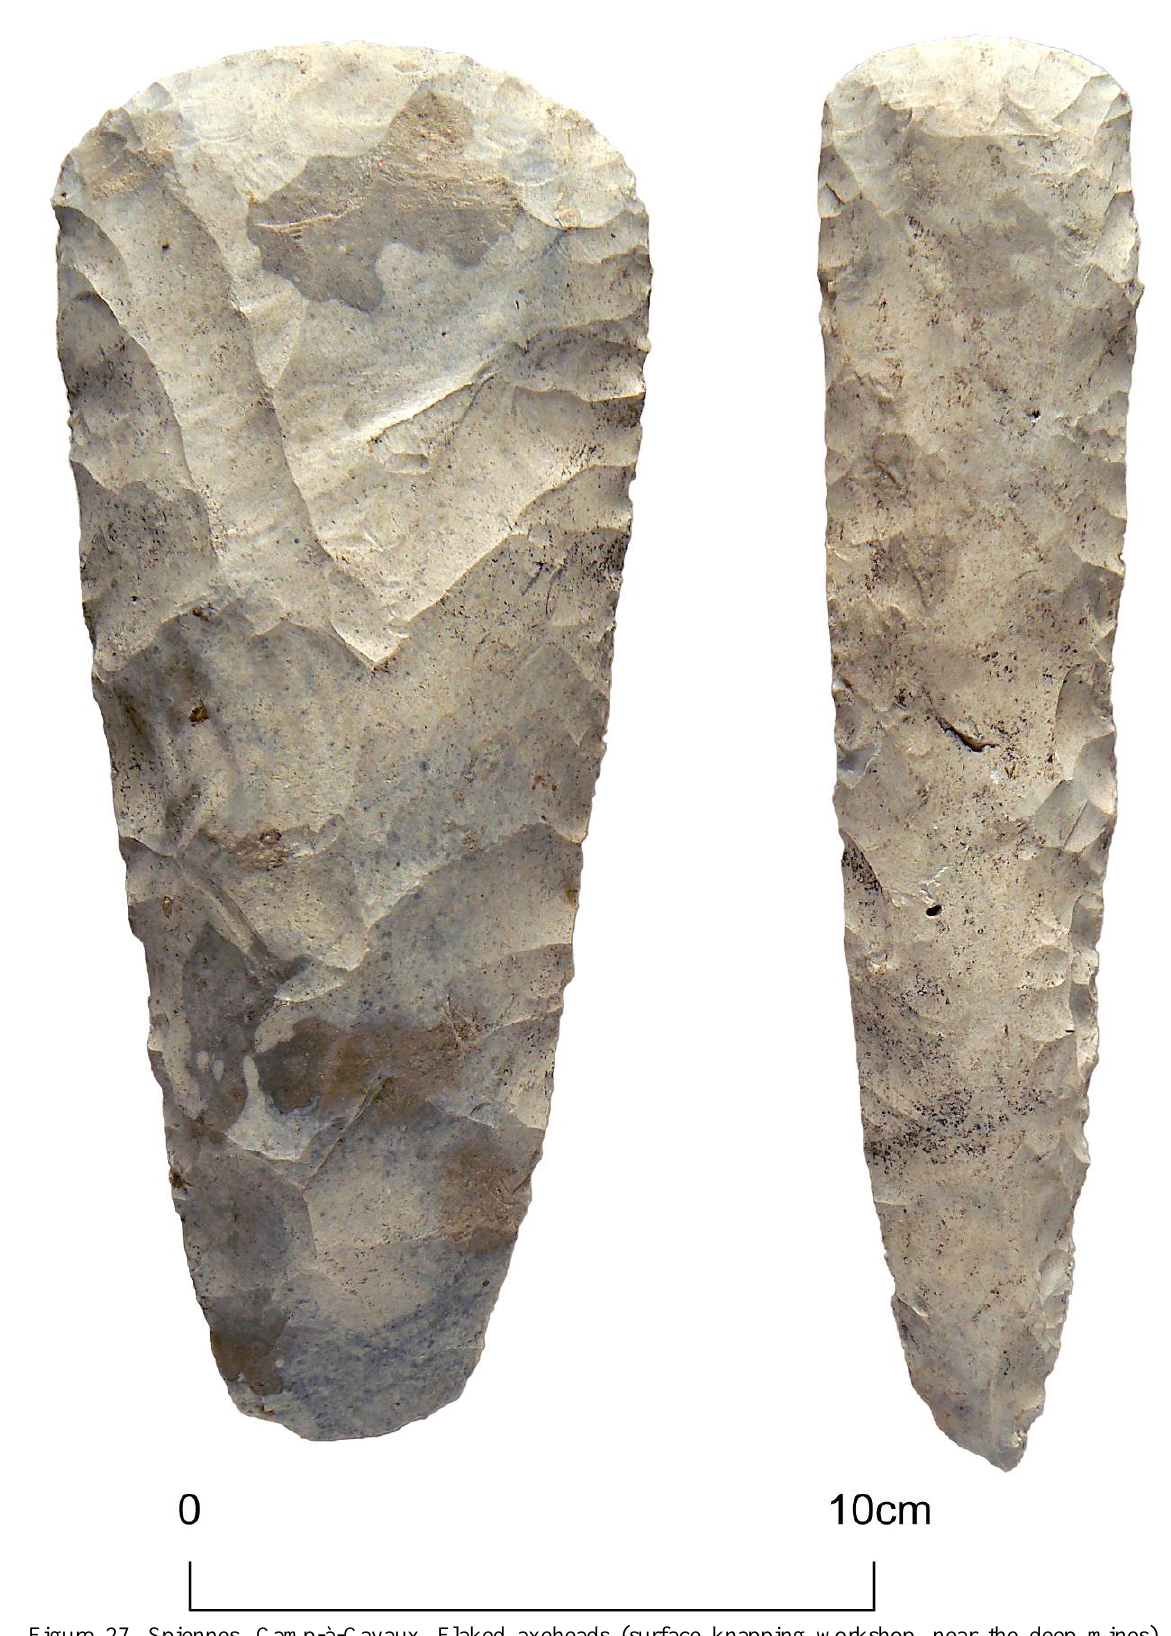
Figure 27. Spiennes, Camp-à-Cayaux. Flaked axeheads (surface knapping workshop, near the deep mines). Photo by M. Woodbury,